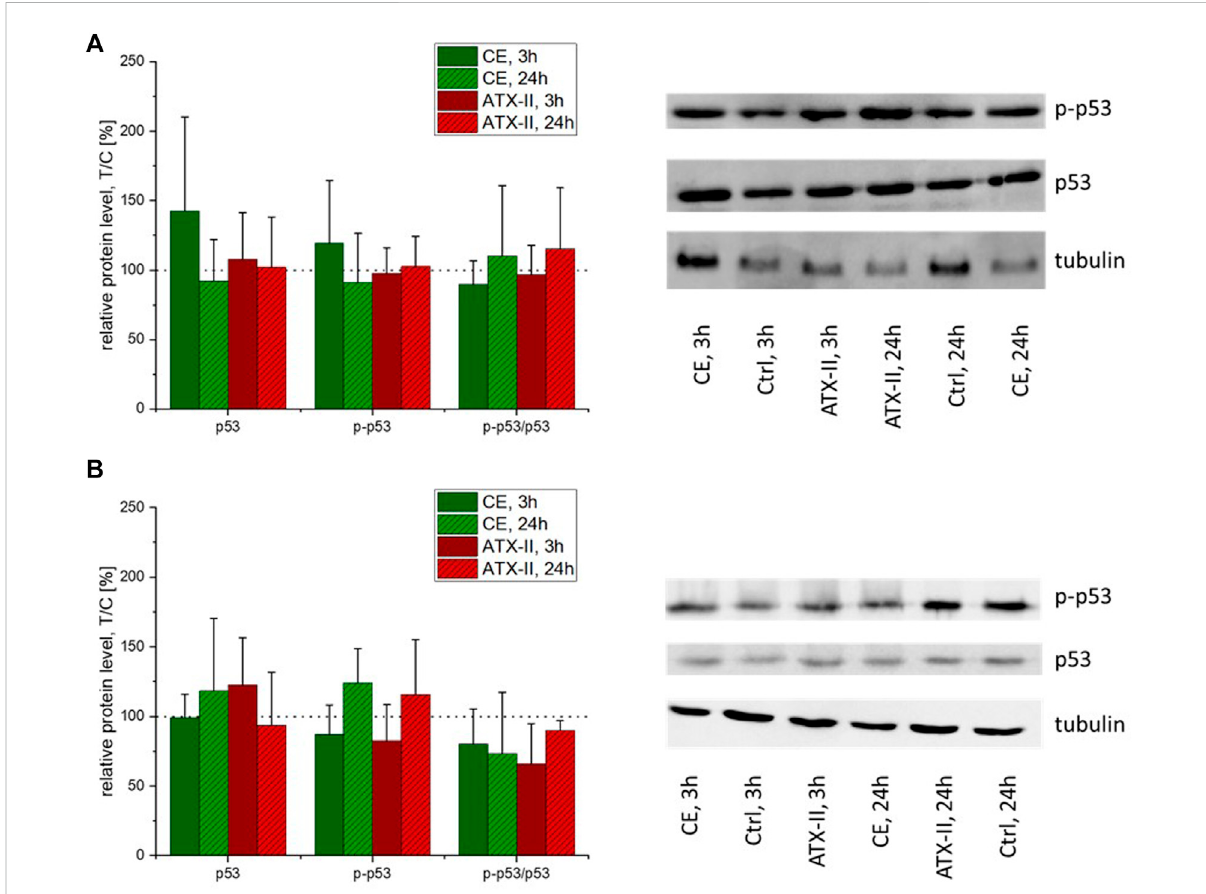
FIGURE 4 Nativeandphosphorylated p53levelsin (A) colonor (B) livertissueofratsexposedtoacomplexextract(CE)ofan Alternaria alternatacultureor altertoxin II (ATX-II), as measured by SDS-PAGE/Western blotting. Graphs depict protein concentrations in relation to the respective vessel control group (indicated by a dotted line), as means + SD of seven animals per group. One-way ANOVA testing was carried out but revealed no signi fi cant differences ( p < 0.05) of test groups to the respective control groups. Next to the graphs, representative images of immuno-stained Western blotting membranes are given.